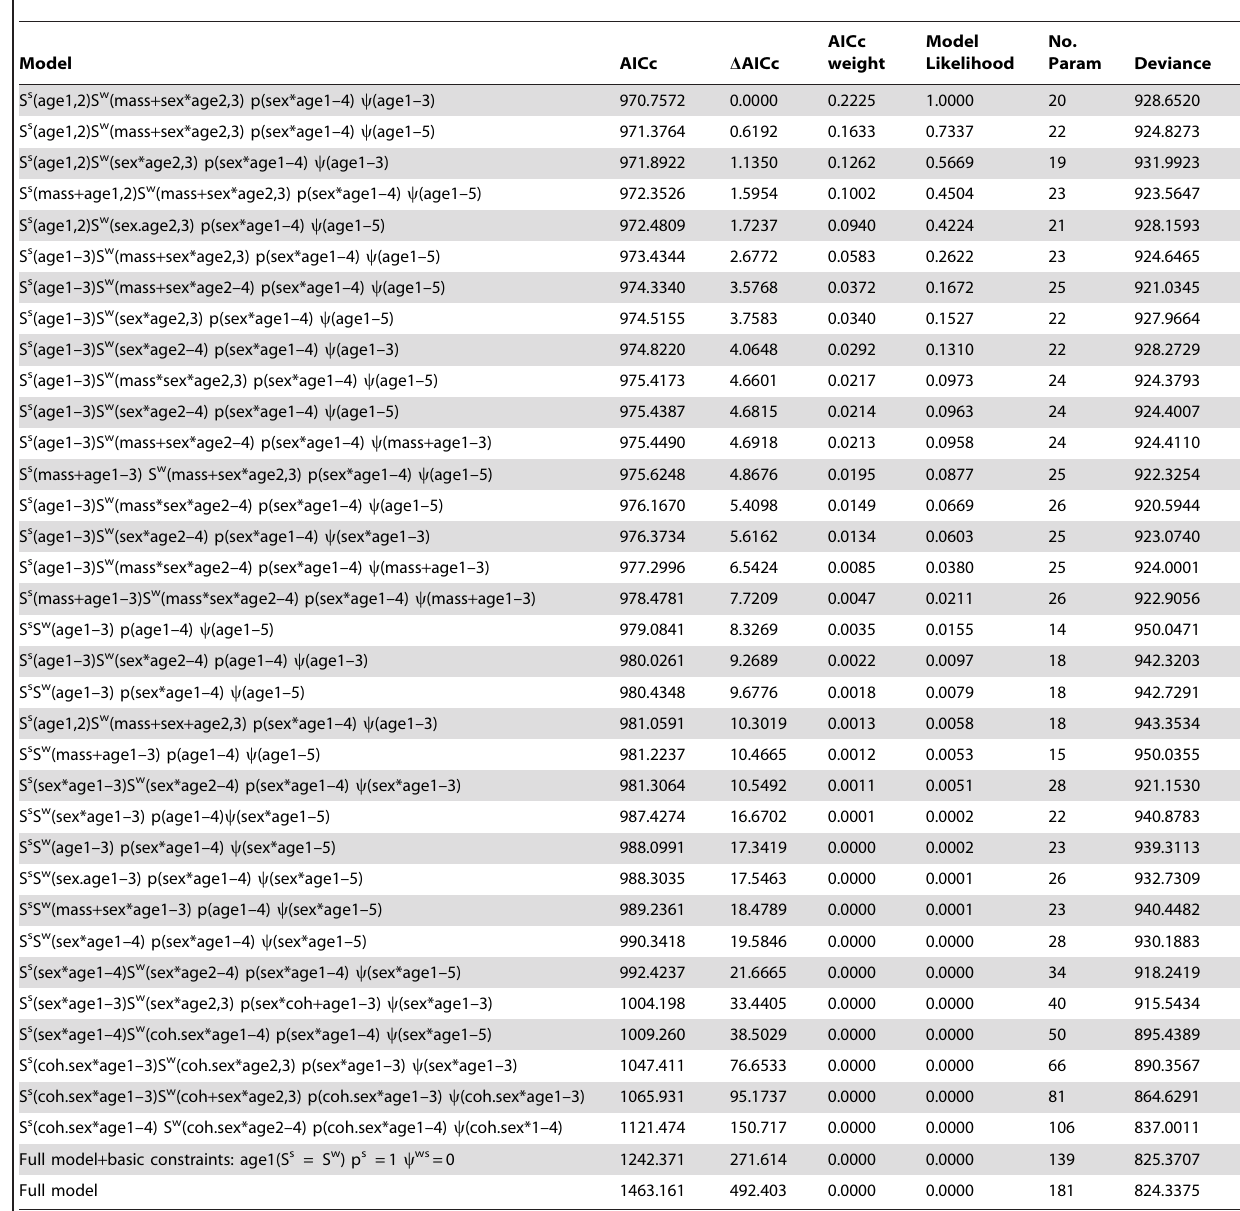
Table 1. Parameter structure for multistate models fit to the data for this study.